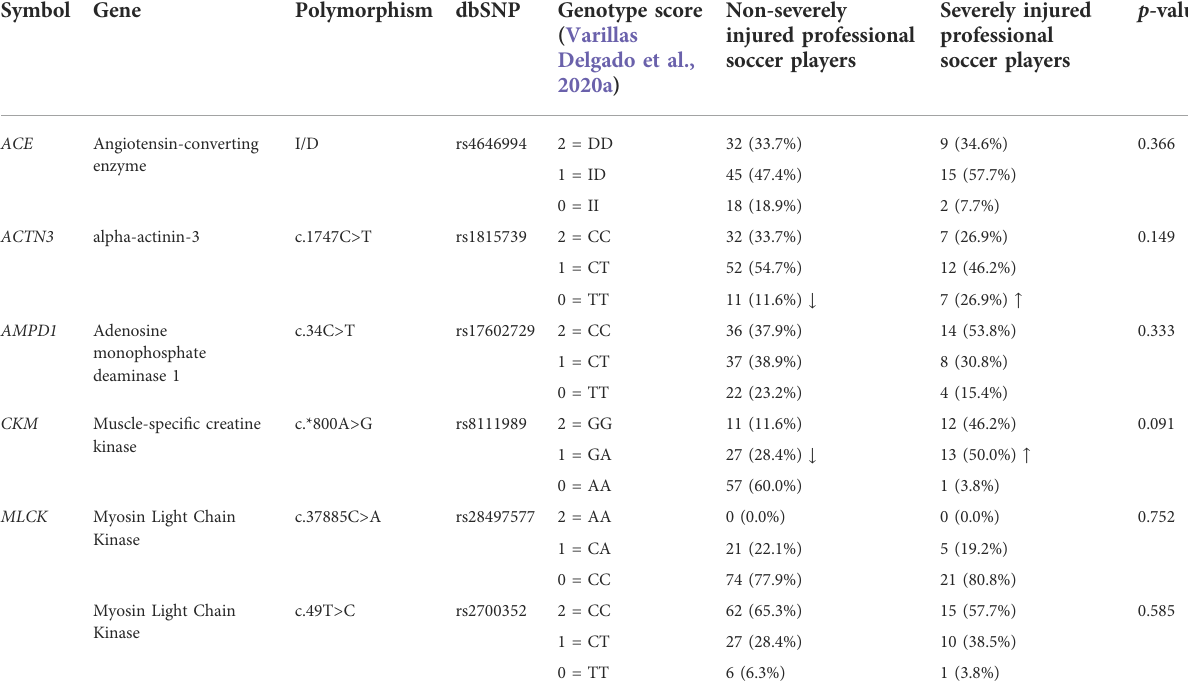
TABLE 8 Genotype distribution in professional soccer players with non-severe and severe injuries for muscle injuries polygenic pro fi